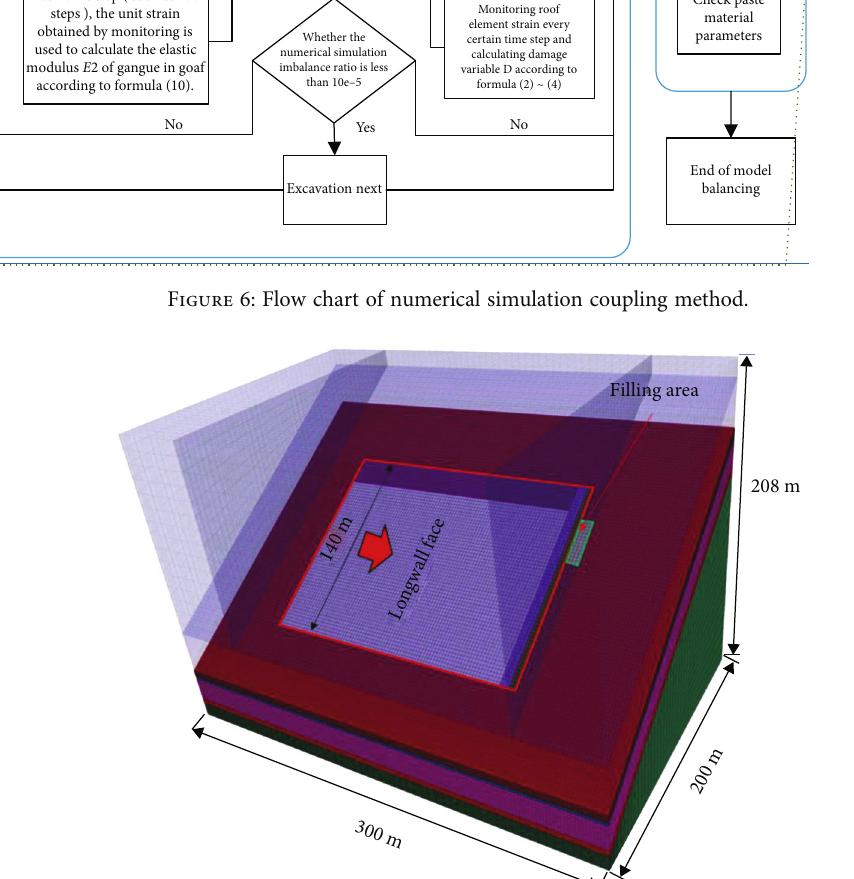
Figure 7: Numerical